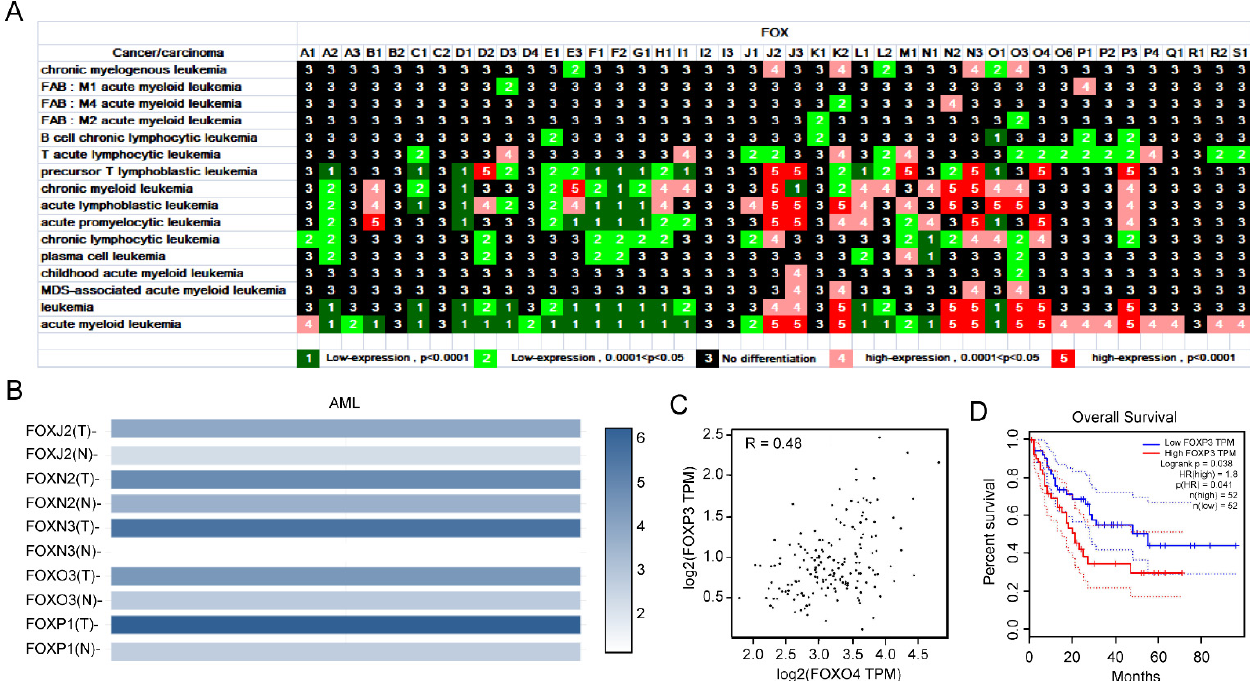
Figure 1. Differential expression of FOX genes in leukemia ( A ). ( B ) The expression of FOXJ2 , FOXN2 , FOXN3 , FOXO3 , and FOXP1 in AML and normal samples. ( C ) The Pearson Correlation analysis of FOXO4 and FOXP3 expression in AML. ( D ) Survival analysis curves of FOXP3 in